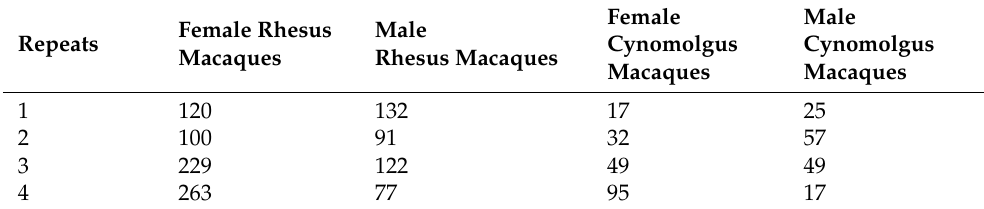
Table 2. Number of repeats by gender and